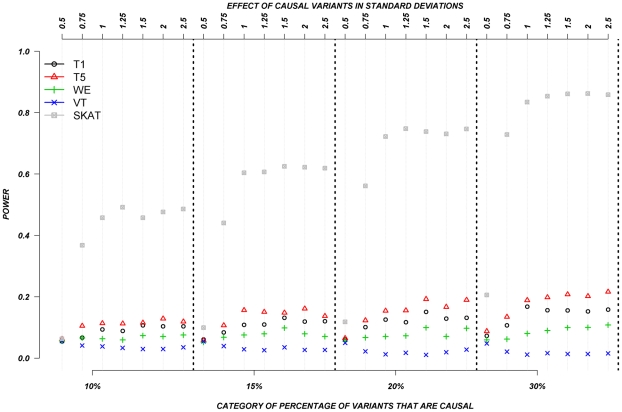
Dichotomous traits: Relationship between effect size, proportion of causal variants, and power, when causal variants are a mixture of protective and deleterious effects.Each box corresponds to a different proportion of causal variants involved in the relationship between rare variants and continuous traits (from left to right, 10, 15, 20 and 30%). On the x-axis, effect sizes are in standard deviations and correspond to the absolute value of the average size effect.